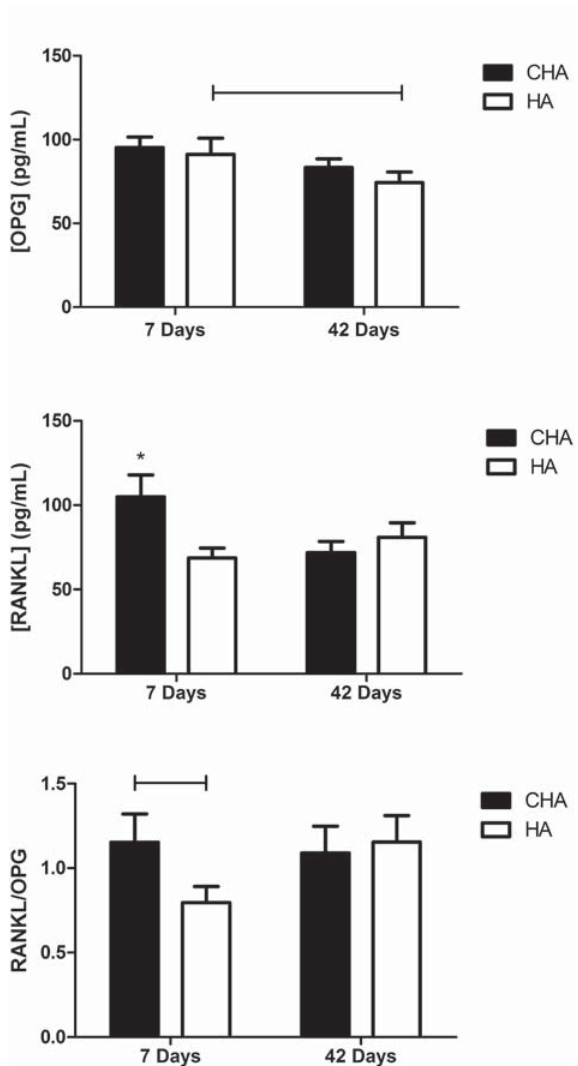
Figure 10- Serum concentrations assay of RANKL/ OPG in operated rats after 7 and 42 days. Abbreviations: CHA=carbonated hydroxyapatite/sodium alginate; (cid:43)(cid:36)(cid:32)(cid:86)(cid:87)(cid:82)(cid:76)(cid:70)(cid:75)(cid:76)(cid:82)(cid:80)(cid:72)(cid:87)(cid:85)(cid:92)(cid:3)(cid:75)(cid:92)(cid:71)(cid:85)(cid:82)(cid:91)(cid:92)(cid:68)(cid:83)(cid:68)(cid:87)(cid:76)(cid:87)(cid:72)(cid:17)(cid:3)(cid:37)(cid:68)(cid:85)(cid:3)(cid:143)(cid:3)(cid:69)(cid:72)(cid:87)(cid:90)(cid:72)(cid:72)(cid:81)(cid:3)(cid:74)(cid:85)(cid:82)(cid:88)(cid:83)(cid:86)(cid:3) (cid:11)(cid:83)(cid:31)(cid:19)(cid:17)(cid:19)(cid:24)(cid:12)(cid:30)(cid:3)(cid:13)(cid:3)(cid:143)(cid:3)(cid:68)(cid:79)(cid:79)(cid:3)(cid:87)(cid:75)(cid:72)(cid:3)(cid:82)(cid:87)(cid:75)(cid:72)(cid:85)(cid:3)(cid:74)(cid:85)(cid:82)(cid:88)(cid:83)(cid:86)(cid:3)(cid:11)(cid:83)(cid:31)(cid:19)(cid:17)(cid:19)(cid:24)(cid:12) intended to interact with the material during new bone formation 20